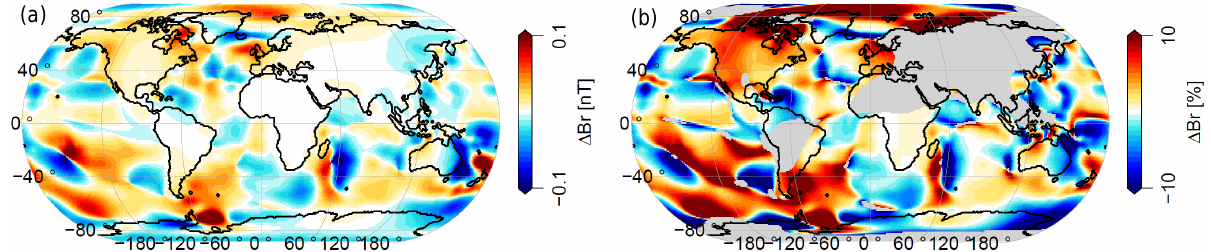
Figure 3. Differences in radial tidal magnetic field at satellite height. FES2014 minus HAMTIDE amplitudes, i.e., two assimilative models. (a) Absolute differences. (b) Relative differences (regions of tidal signal strength below 0.1nT are grayed